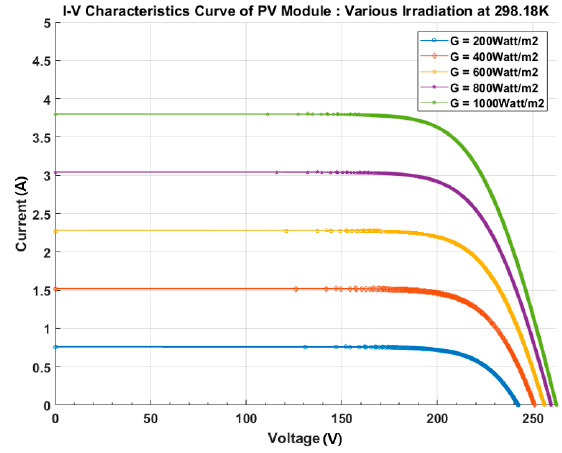
Figure 10. PV Array I-V Curve with various irradiation levels.